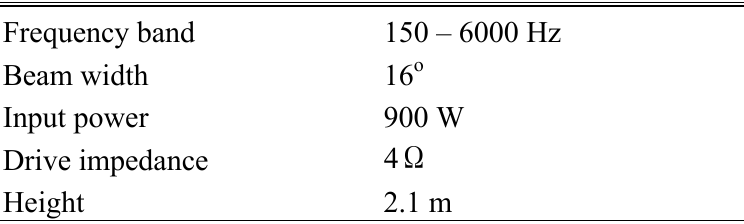
Table1 . Specification of Doppler Sodar